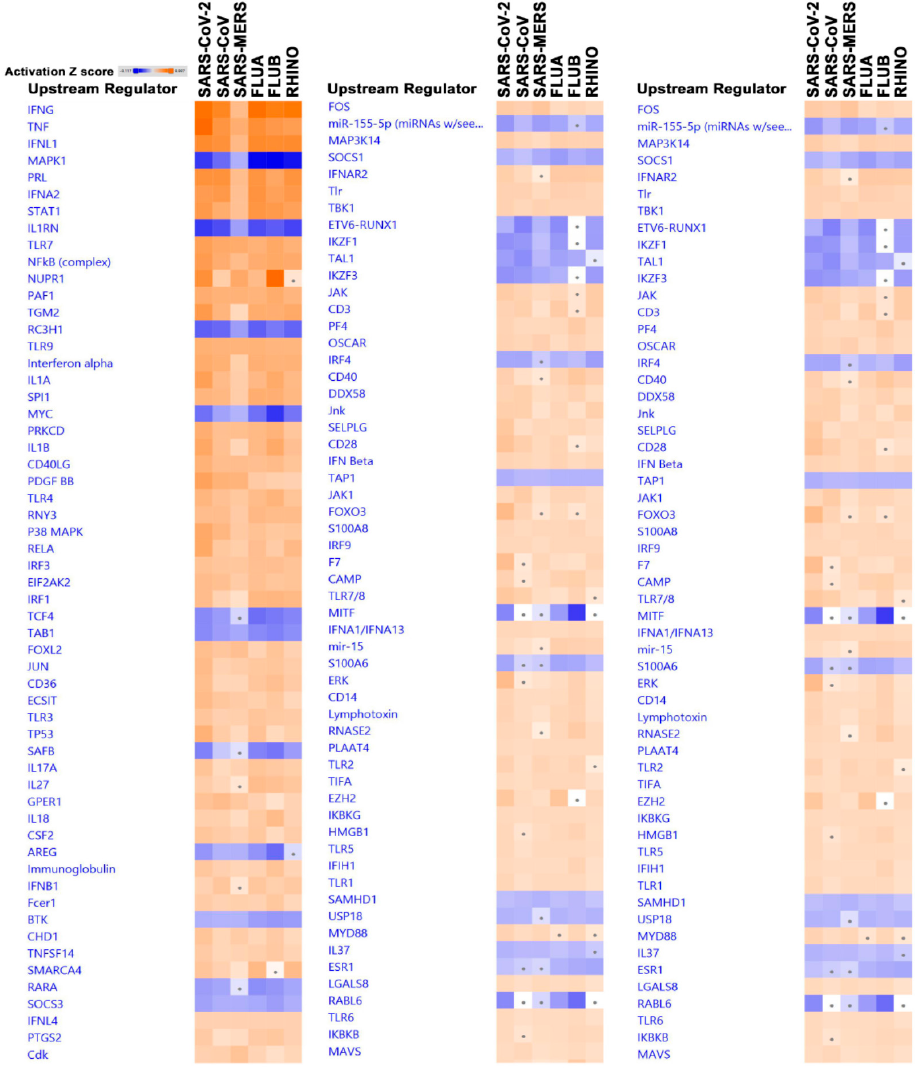
Figure 5. Significantly a ff ected upstream regulator analysis based on di ff erentially expressed genes in the indicted treatment group (SARS-CoV-2, SARS-CoV, SARS-MERS, FLUA, FLUB, and RHINO) in Calu-3 cells. Di ff erentially expressed genes from the six virally infected Calu-3 cells were subjected to upstream regulator analysis in IPA. Activation Z score is depicted according to the color scale (2.0 ≤ Z score ≤ − 2.0). Red indicates activation, while blue indicates suppression. Squares with a filled circle denote canonical with an activation Z score <